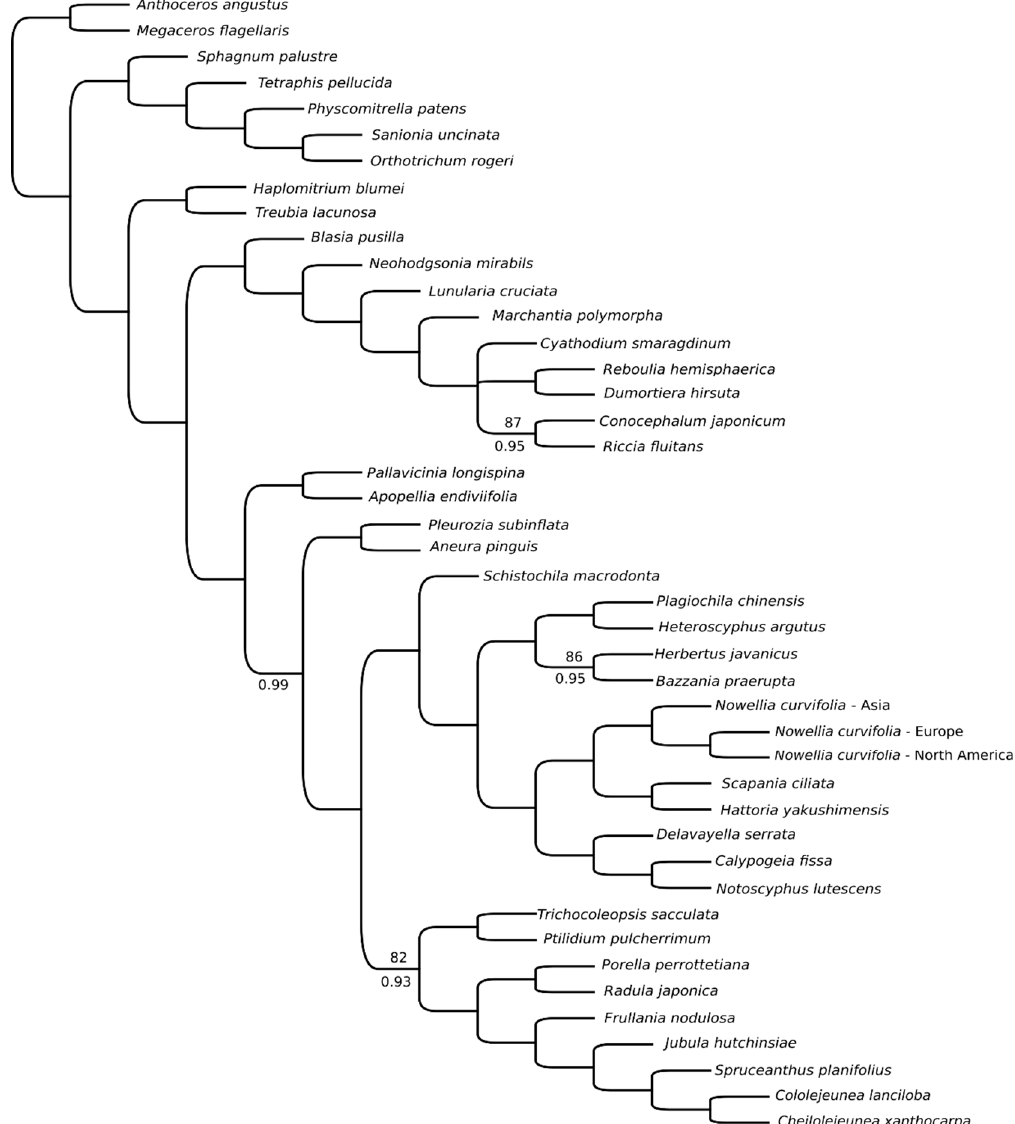
Figure 4 . Phylogenetics relationships of 44 bryophyte species based on protein-coding sequences obtained using ML analysis. Bootstrap values lower than 100 are given at the nodes. Bayesian inference resulted in a tree with congruent topology and PP values lower than 1 are given below branches.